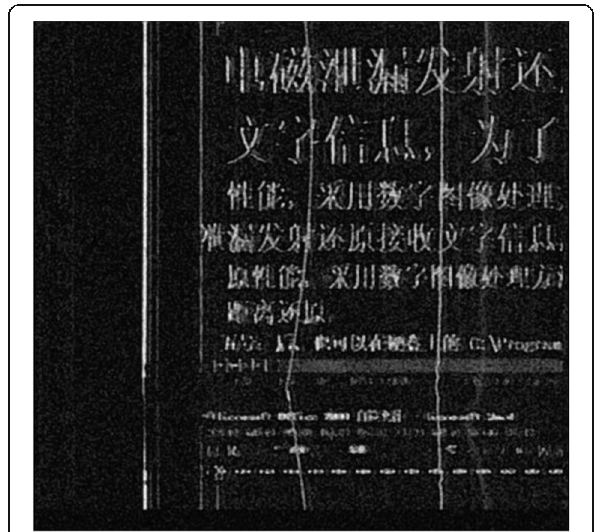
Fig. 10 Weighted mean filtering → blur sharpening → grayscale